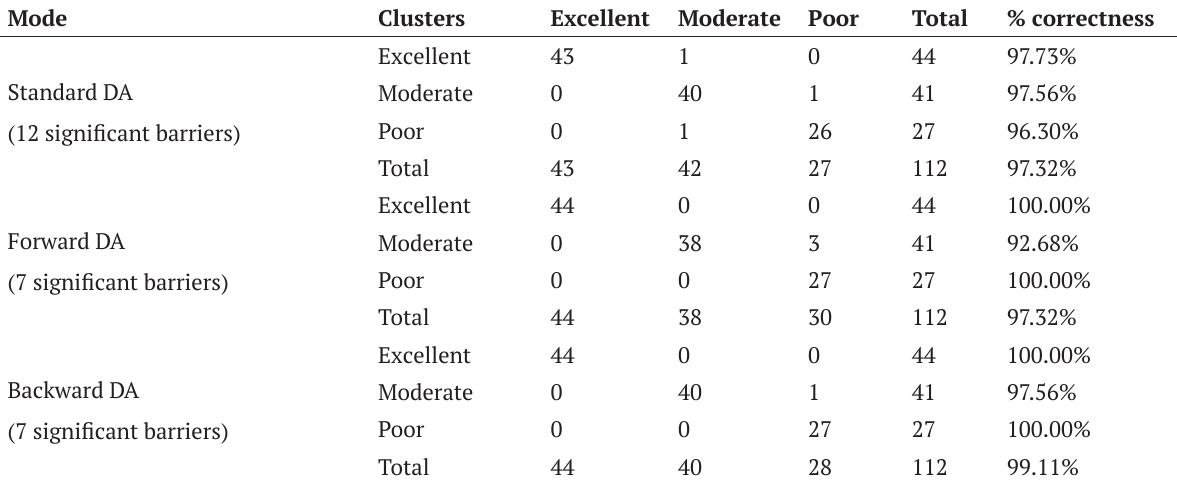
Table 2. Classification matrix of Discriminant Analysis (DA) for the relative barrier variations in the three different clusters of PE teachers.